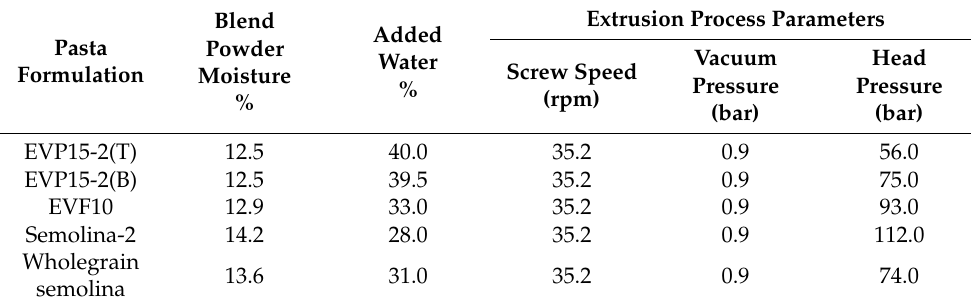
Table 2. Operative parameters for pasta production. Pasta Formulation